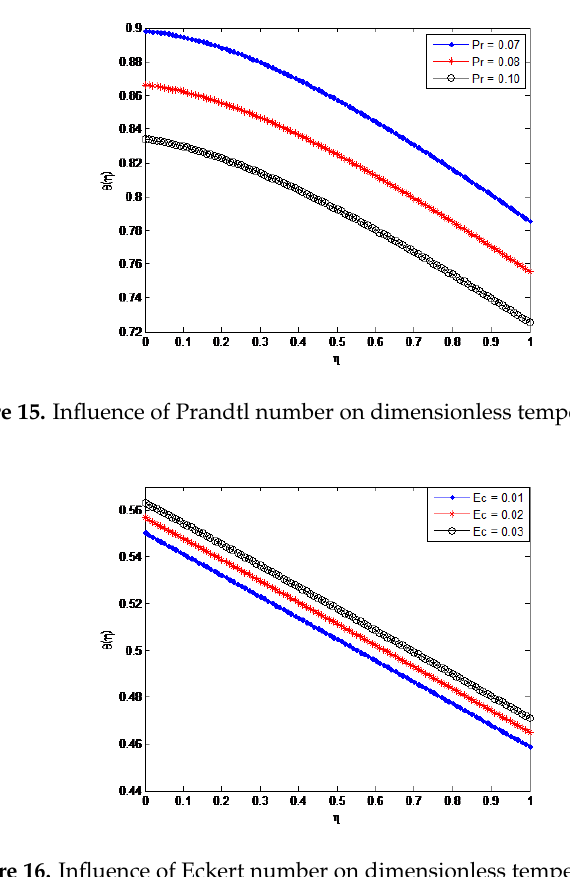
Figure 16. Influence of Eckert number on dimensionless temperature profile